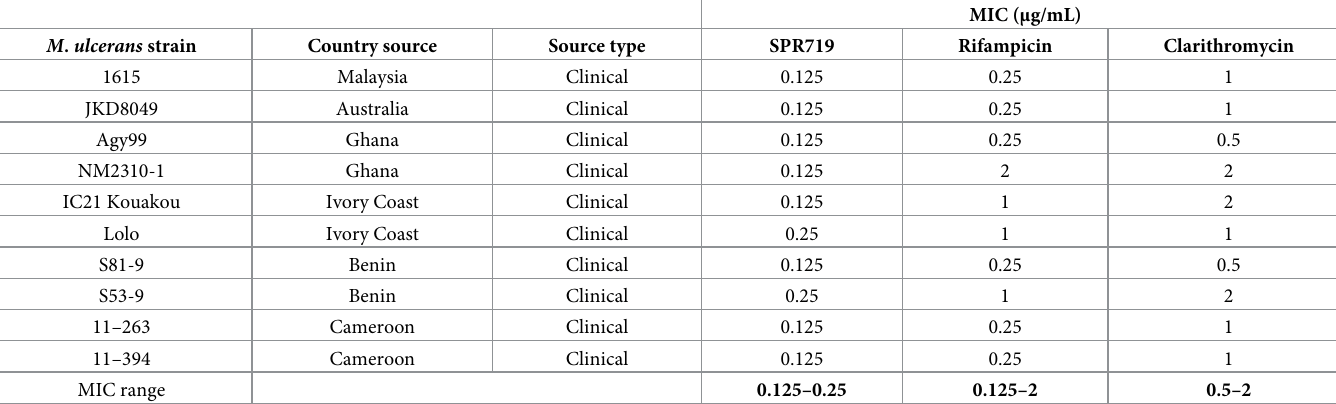
Table 1. M . ulcerans strains used in this study and their MICs.